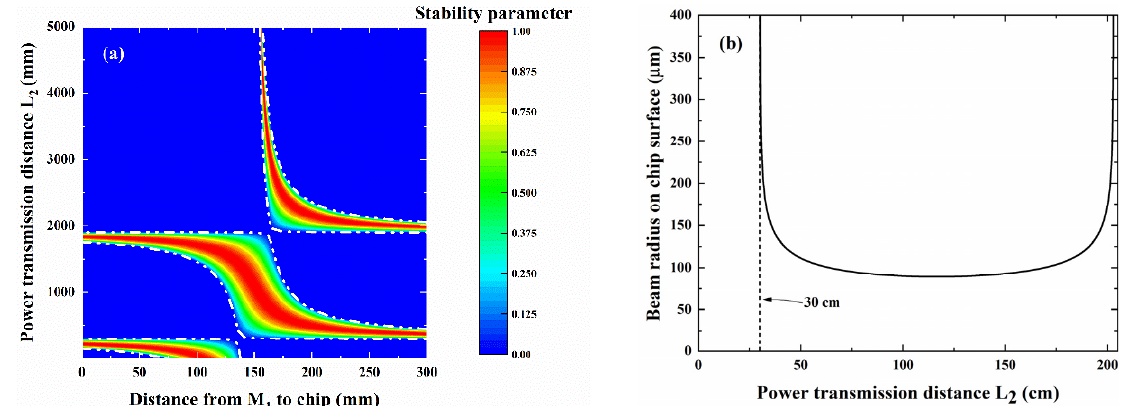
Figure 4. Simulation results after redesigning the cavity parameters. ( a ) Influence of the cavity lengths L 1 and L 2 in the VECSEL on the cavity stability. The area enclosed by the white dotted line is the working area for cavity stabilization. ( b ) Beam radius of the cavity on the chip surface varying with the cavity length L 2 .